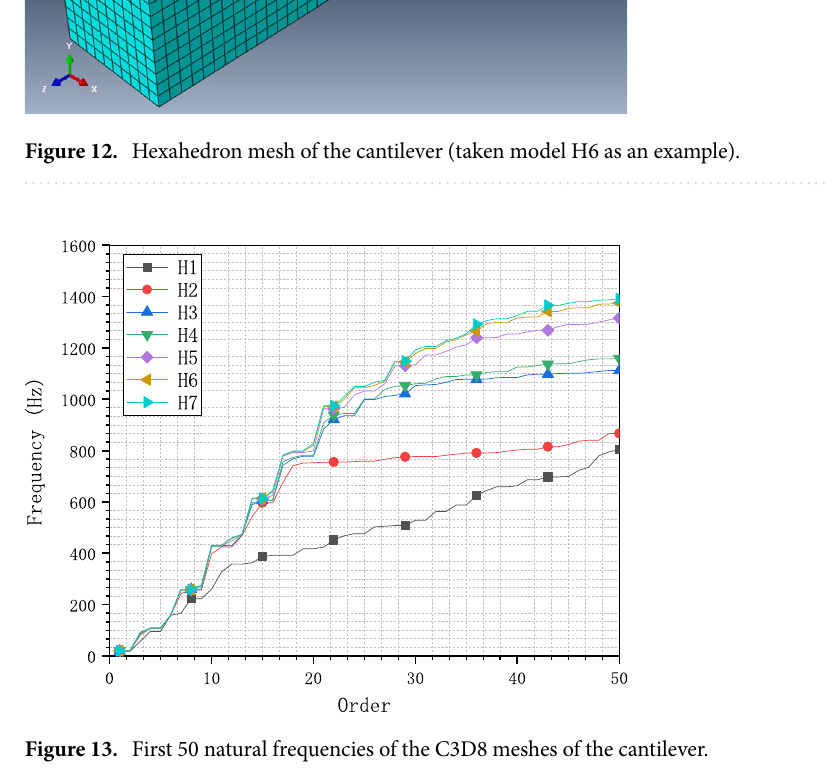
Figure 13. First 50 natural frequencies of the C3D8 meshes of the cantilever.